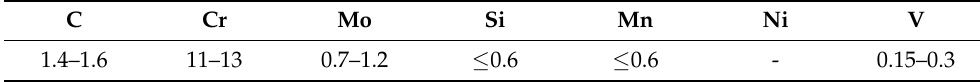
Table 1. Chemical compositions of SKD11 alloy steel (% mass) [20].